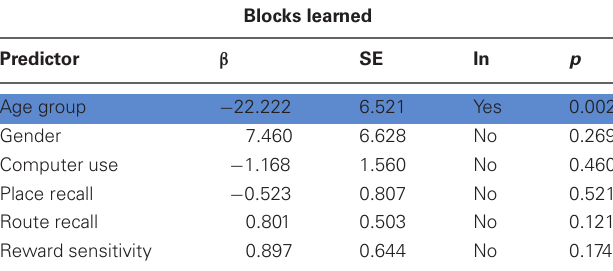
Table 2 | Results of stepwise regression analysis predicting blocks learned, with significant predictors (age group) highlighted in blue.